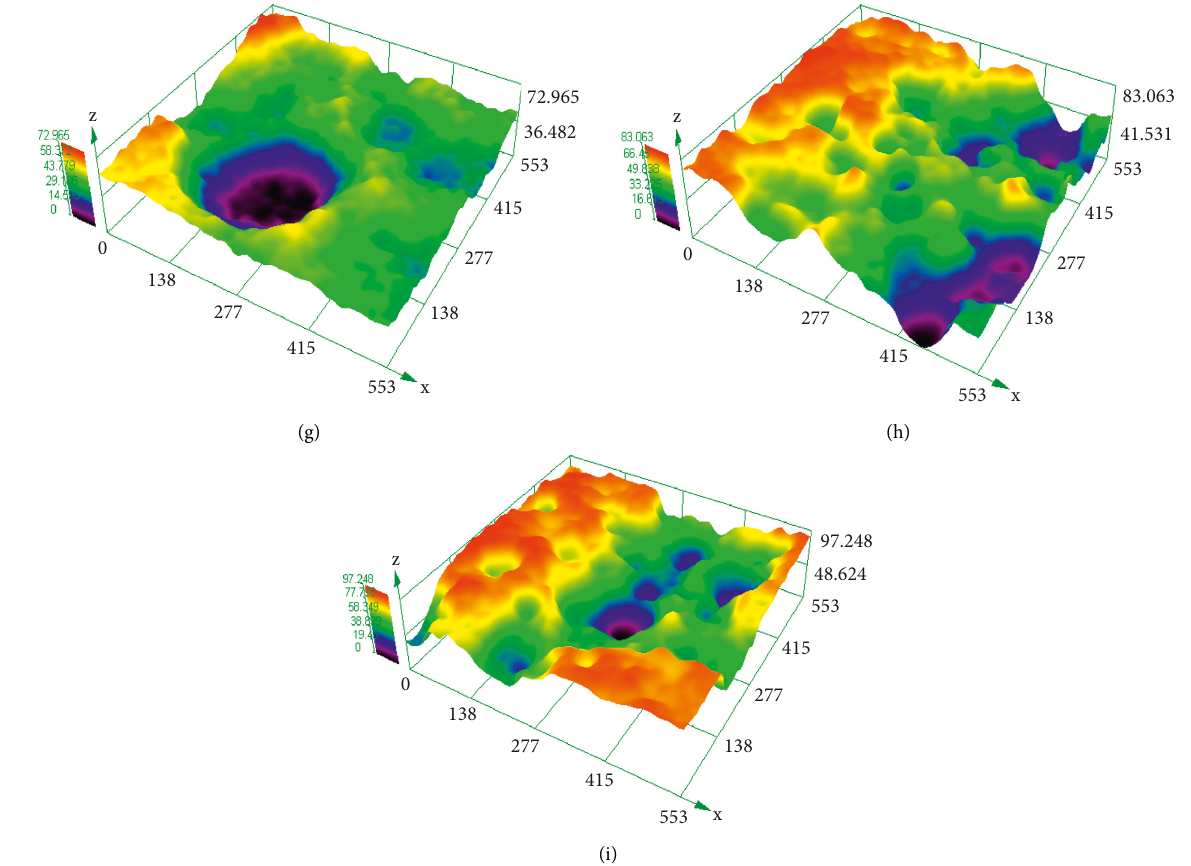
Figure 5: Surface morphology of corroded carbon steel (scale bar unit: μ m). (a) 0h. (b) 1h. (c) 2h. (d) 4h. (e) 8 h. (f) 12h. (g) 24 h. (h) 48h. (i) 72